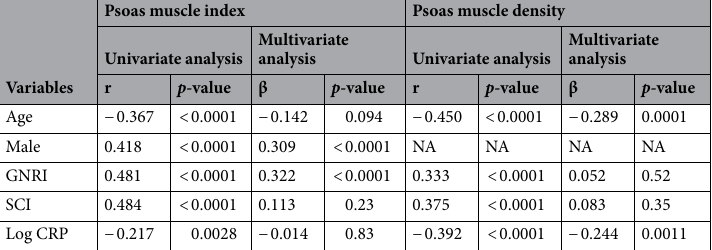
Table 2. Regression analysis of the associations of the psoas muscle index and psoas muscle density with baseline variables. GNRI geriatric nutritional risk index, SCI simplified creatinine index, CRP C-reactive protein, NA not